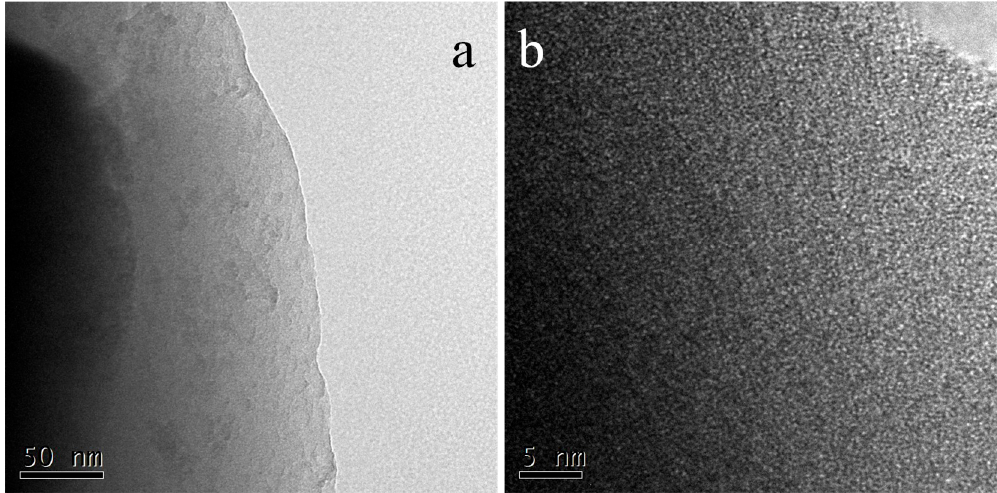
Figure 3. HRTEM images of MZ-9-3.2 with ( a ) low magnification and ( b ) high magnification.